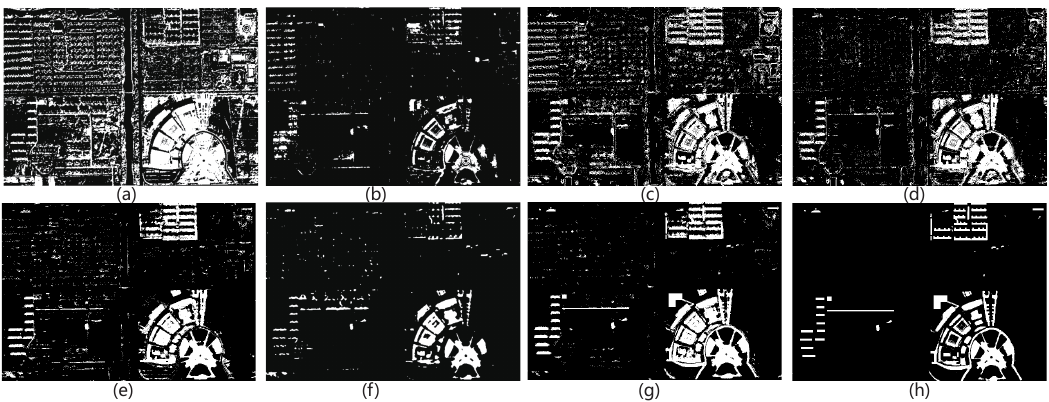
Figure 10. Binary change maps of Minfeng data set. ( a ) CVA. ( b ) IRMAD. ( c ) SCCN. ( d ) S-CNN+Threhold. ( e ) S-CNN+SVM. ( f ) SRDL. ( g ) Our proposed SSJLN. ( h ) Ground truth. The unchanged samples are black and changed samples are